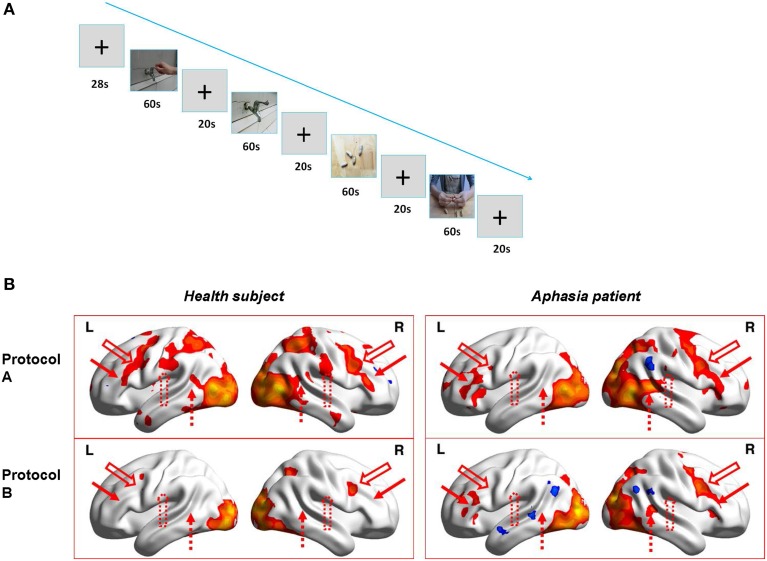
The fMRI experiment design and results. (A) Figure Demo of the video blocks of Run1 in fMRI experiment (i.e., Protocol ABBA; Run2 is Protocol BAAB). (B) 3D illumination of activations for the healthy subject (left) and the patient (right) by Protocol A (upper) and Protocol B (lower). L and R indicate Left and right hemisphere, respectively. Upper left: healthy subject with protocol A; Upper right: patient with protocol A; Lower left: healthy subject with protocol B; Lower right: Patient with protocol B. Red solid arrow is corresponding to posterior inferior frontal gyrus (BA 44-45, left is Broca's area), red hollow arrow is ventral premotor cortex (BA6), red dotted hollow arrow is supramarginal gyrus(BA40), and red dotted arrow indicates posterior superior temporal gyrus (BA 22, left is Wernicke's area).